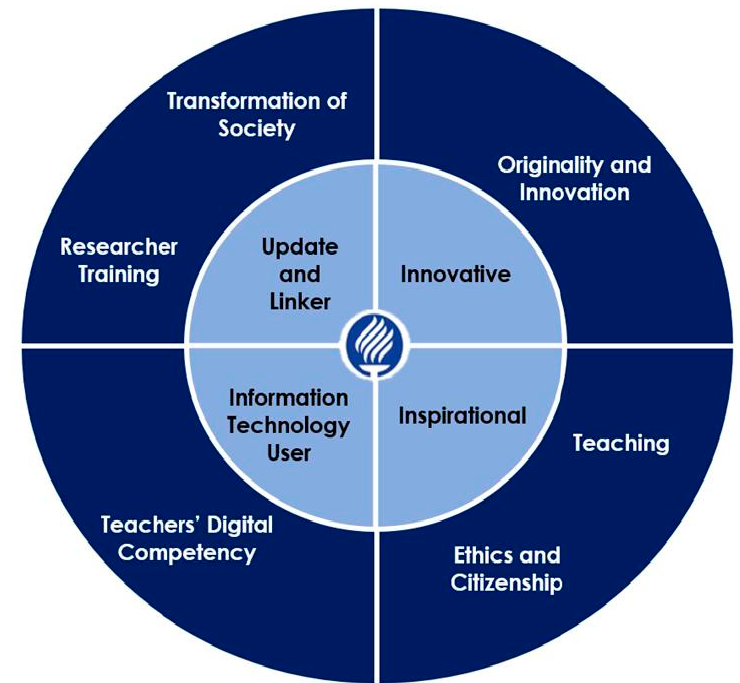
Figure 1. Model for Research Professors’ Competencies. Source: Adapted from [20,21]. Table 1. Domains, Competencies, and Elements of Competencies for Evaluation of Research Professors .